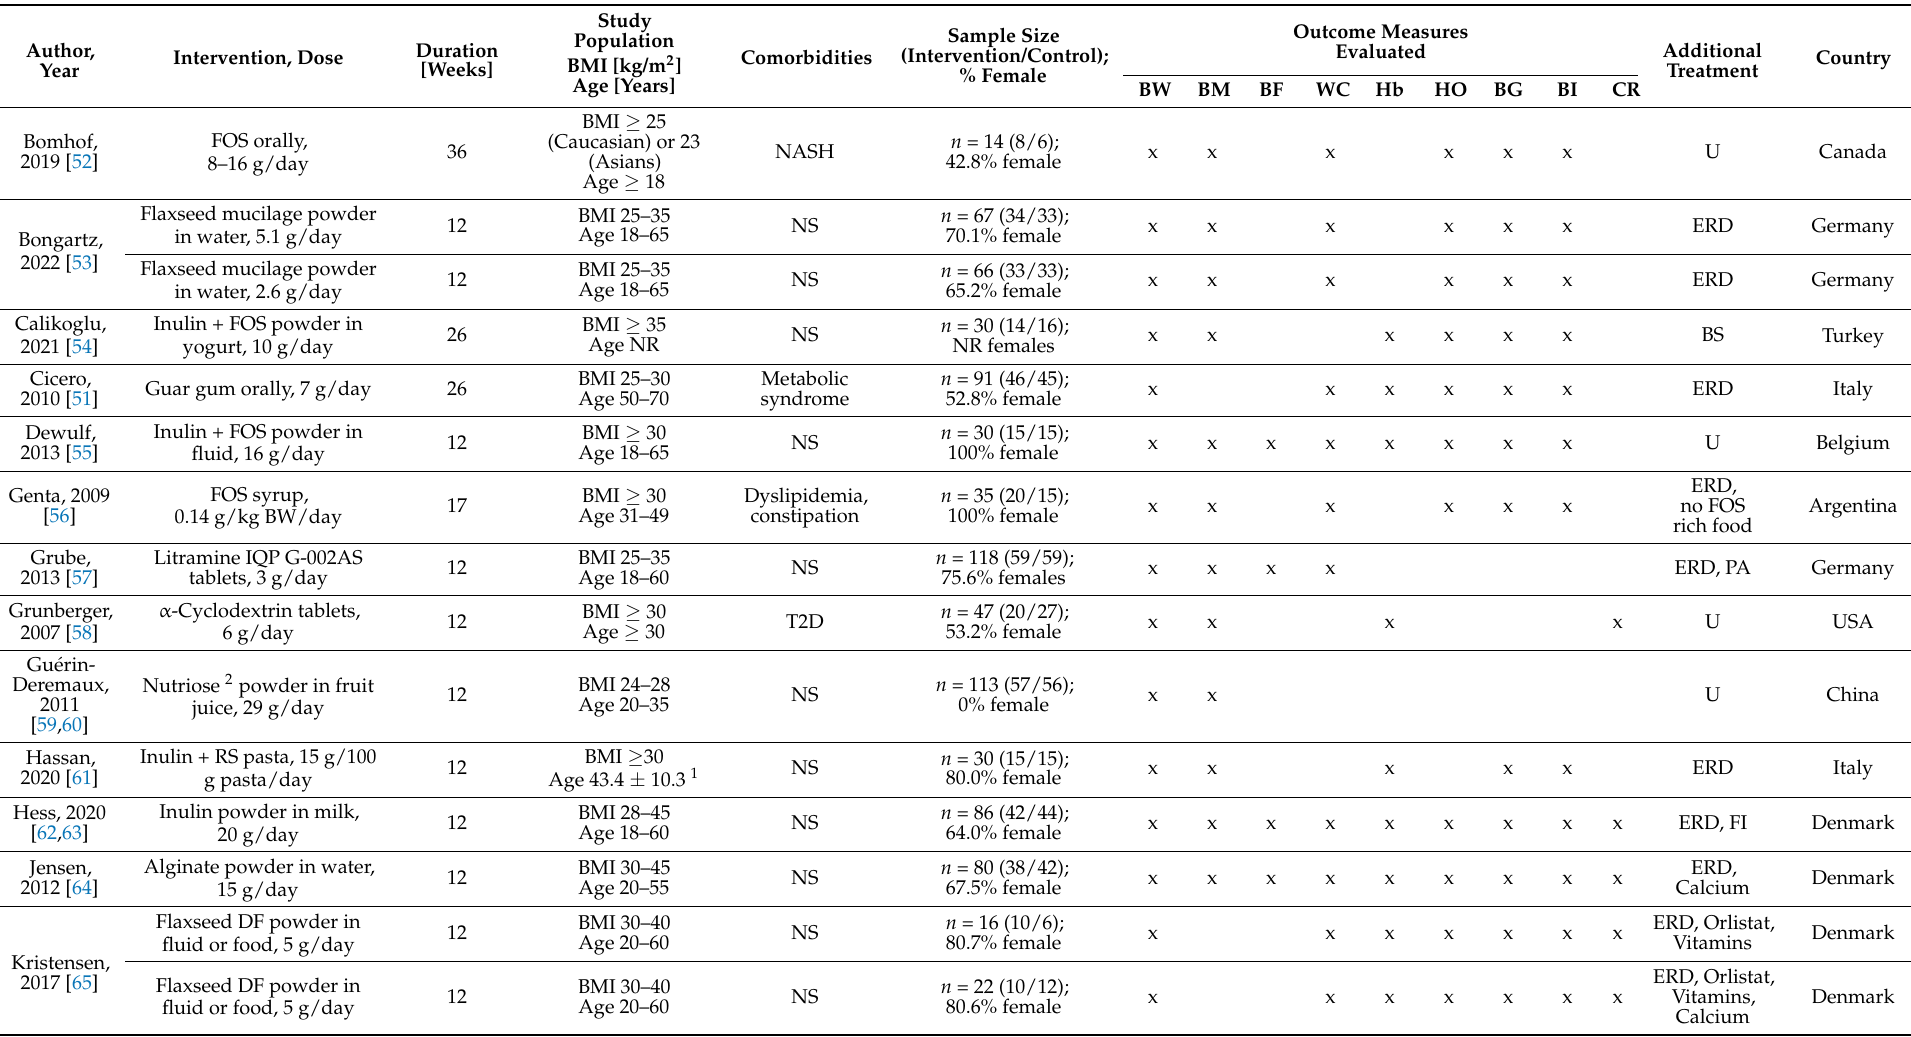
Table 1. Study and participant characteristics of the 22 included randomised controlled